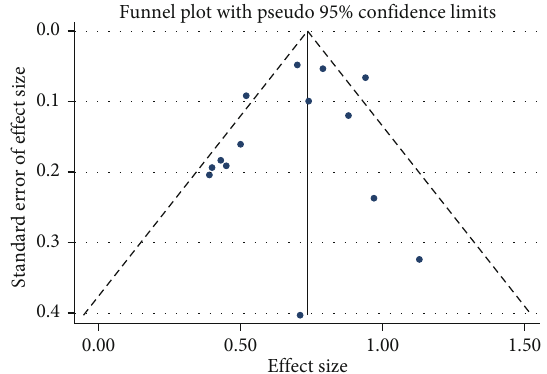
Figure 4: Funnel plot for detection of publication